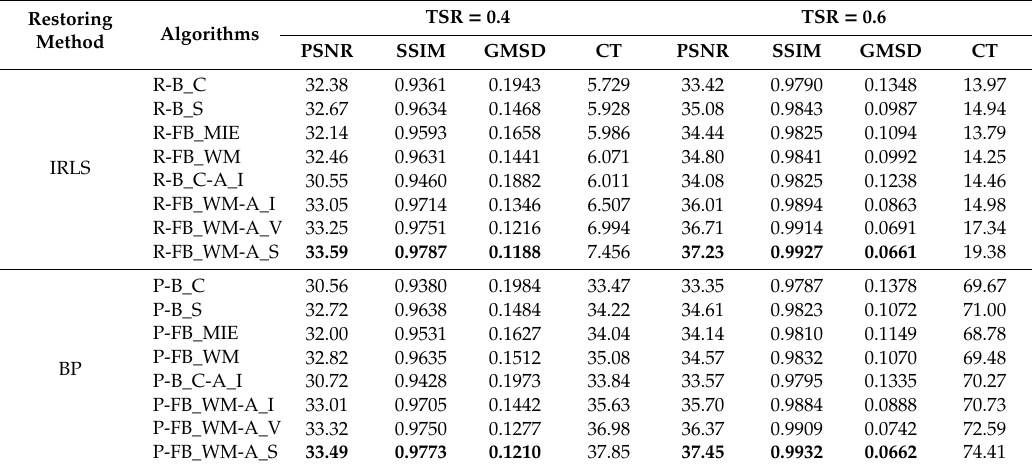
Table 2. The PSNR and SSIM of reconstructed images with eight BCS algorithms based on iteratively reweighted least square (IRLS) and basis pursuit (BP).